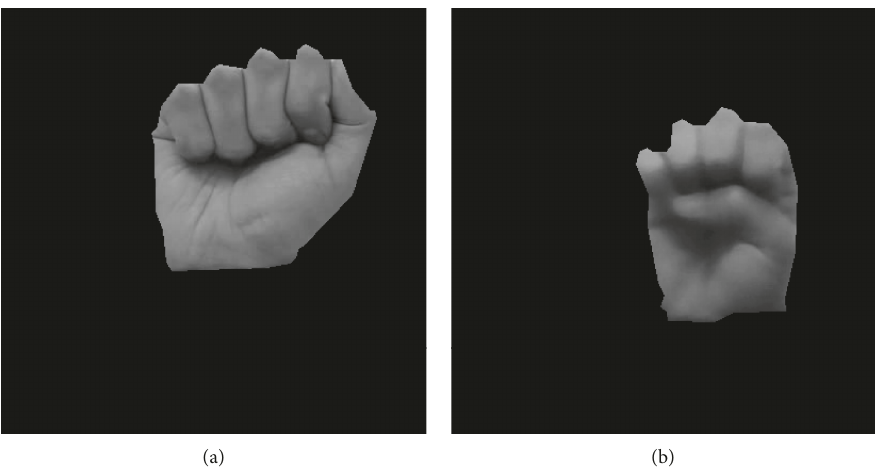
Figure 12: Gestures A (a) and E (b) after AND logical operation with the hand segmented image.